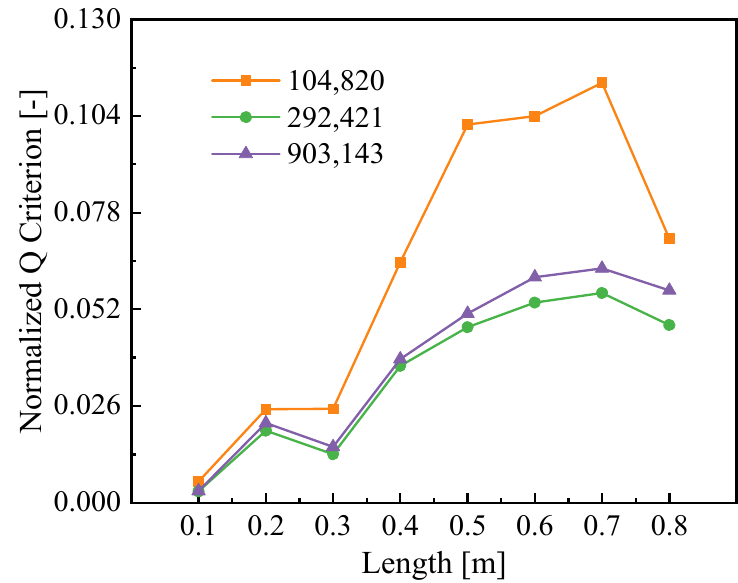
Figure 2. The normalized Q criterion number (Q) of three kinds of grids.